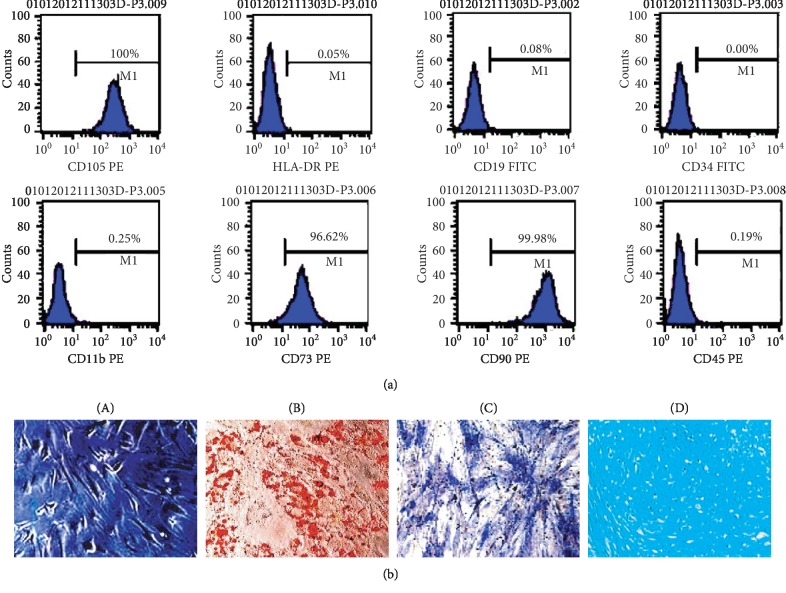
Phenotypic characterization and differentiation of hUC-MSCs. (a) Flow cytometry showing that isolated cultured hUC-MSCs highly expressed CD105, CD73, and CD90 and were negative for hematopoietic markers CD19, CD34, and CD45 and for the lymphocyte surface marker HLA-DR. (b) (A) Gross morphology of hUC-MSCs under light microscopy, (B) oil-red-O staining for the adipogenic differentiation of hUC-MSCs after 3 weeks, (C) endogenous alkaline phosphatase staining for the osteogenic differentiation of hUC-MSCs, and (D) Alcian blue staining of hUC-MSCs after 3 weeks for chondrogenic differentiation (scale bar = 100 μm).